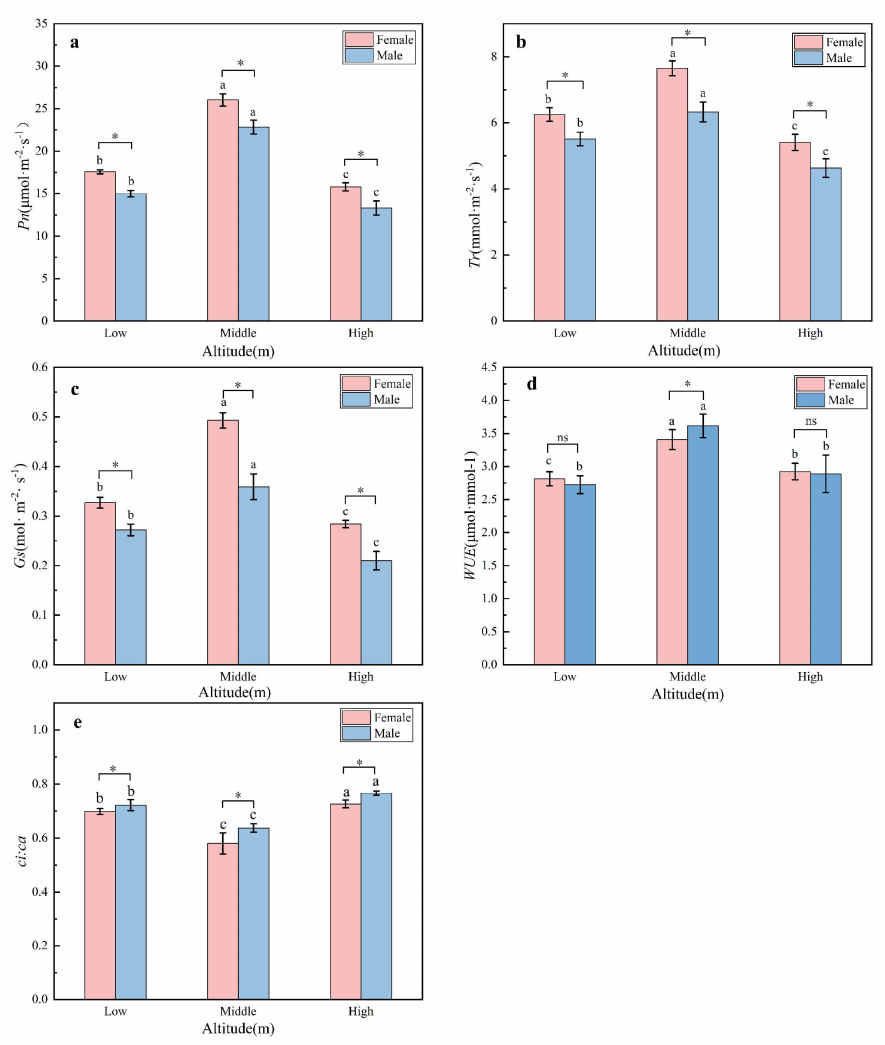
Figure 5. Photosynthetic parameters of male and female leaves of H. tibetana at different altitudes. ( a ) Pn at three altitude field sites; ( b ) Tr at three altitude field sites; ( c ) Gs at three altitude field sites; ( d ) WUE at three altitude field sites; ( e ) the ratio of intercellular CO 2 concentration to atmospheric CO 2 concentration ( ci:ca ) at three altitude field sites. To keep other environmental factors consistent, the three altitudes are set to the same photosynthetically active radiation PAR (1500 µ mol · m − 2 · s − 1 ). The leaf temperature is controlled at about 25 ◦ C, the relative humidity was about 60% and the atmospheric CO 2 concentration (about 400 µ mol · mol − 1 ) was adjusted with reference to the CO 2 concentration. Other parameters are default values, and the time of measurement was between 9:00–11:30 a.m. “*” and “ns” indicate significant differences and no significant differences between male and female plants at the same elevation gradient, respectively. a, b, c indicate that there is a significant difference in the mean from large to